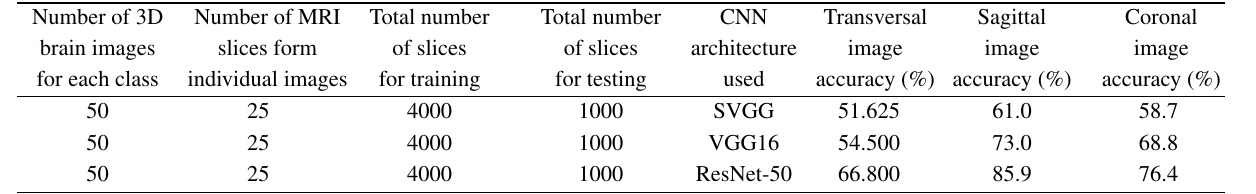
Table 1 Accuracy comparison of results obtained [21]